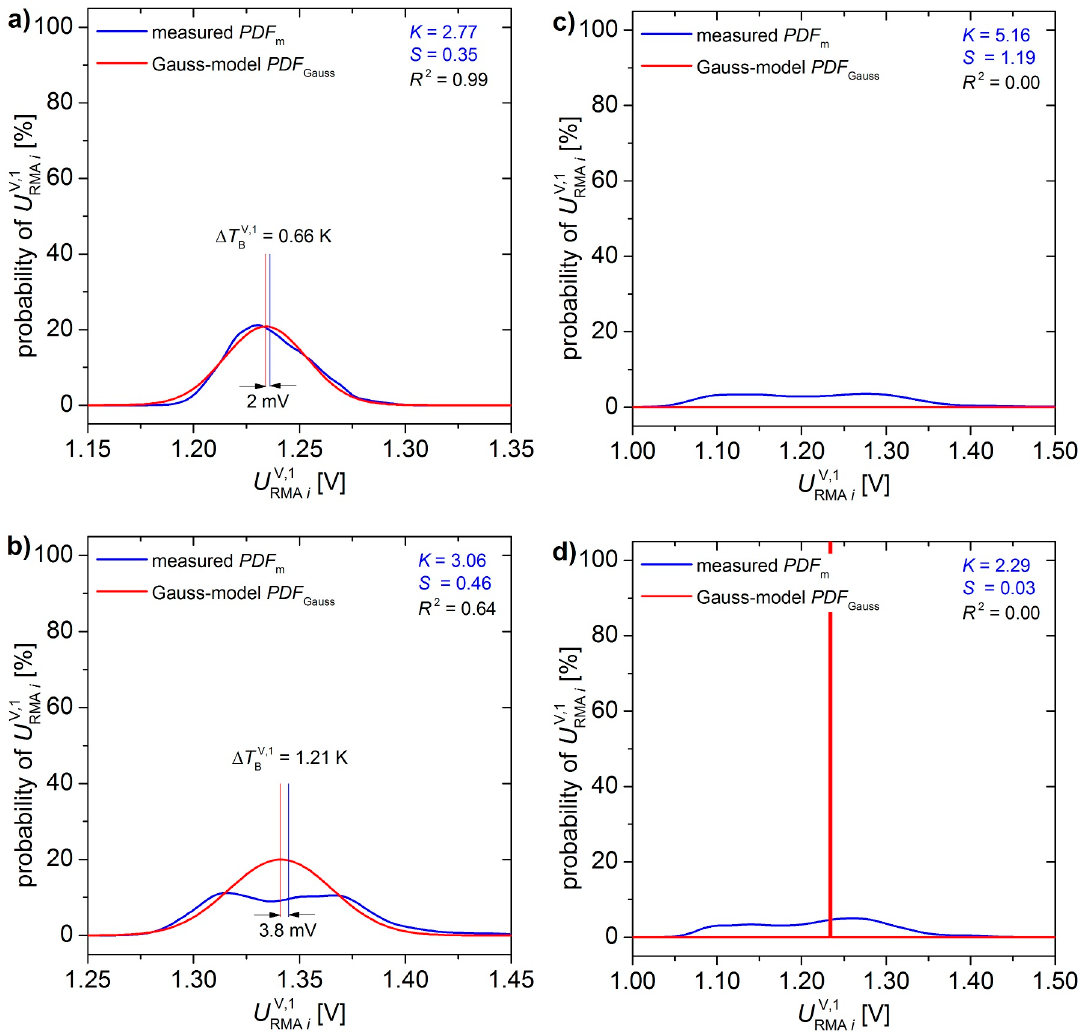
) , and the corresponding Figure 6. Four examples of measured sample voltage distributions PDF m ( U V,1 Figure 6. Four examples of measured sample voltage distributions (cid:1842)(cid:1830)(cid:1832) (cid:2923) ((cid:1847) (cid:2902)(cid:2897)(cid:2885),(cid:3036)(cid:2906),(cid:2869) ) and the RMA, i ) : ( a ) a “healthy” measurement; and ( b – d ) distorted Gaussian fits PDF Gauss ( U V,1 corresponding Gaussian fits (cid:1842)(cid:1830)(cid:1832) (cid:2891)(cid:2911)(cid:2931)(cid:2929)(cid:2929) ((cid:1847) (cid:2902)(cid:2897)(cid:2885),(cid:3036)(cid:2906),(cid:2869) ) : ( a ) a “healthy” measurement; and ( b – d ) distorted RMA, i measurements.